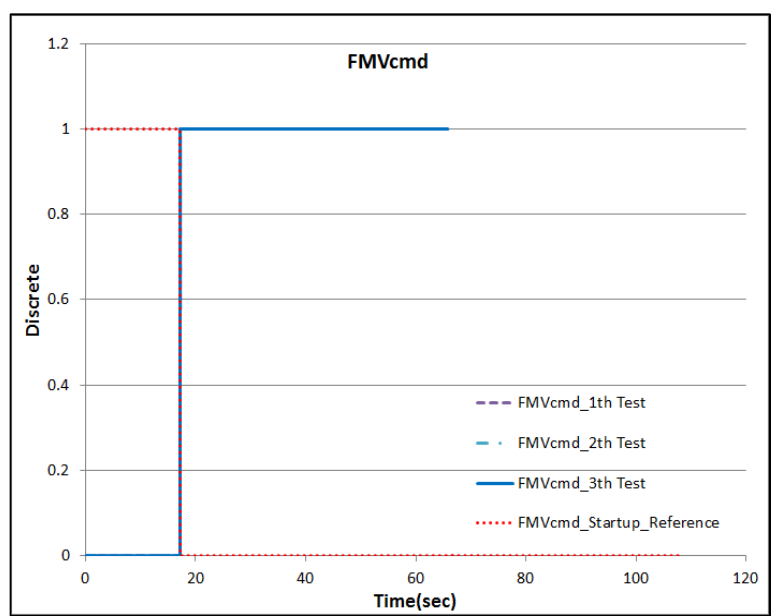
Figure 15. Result of EECU control logic verification test (FSVcmd).